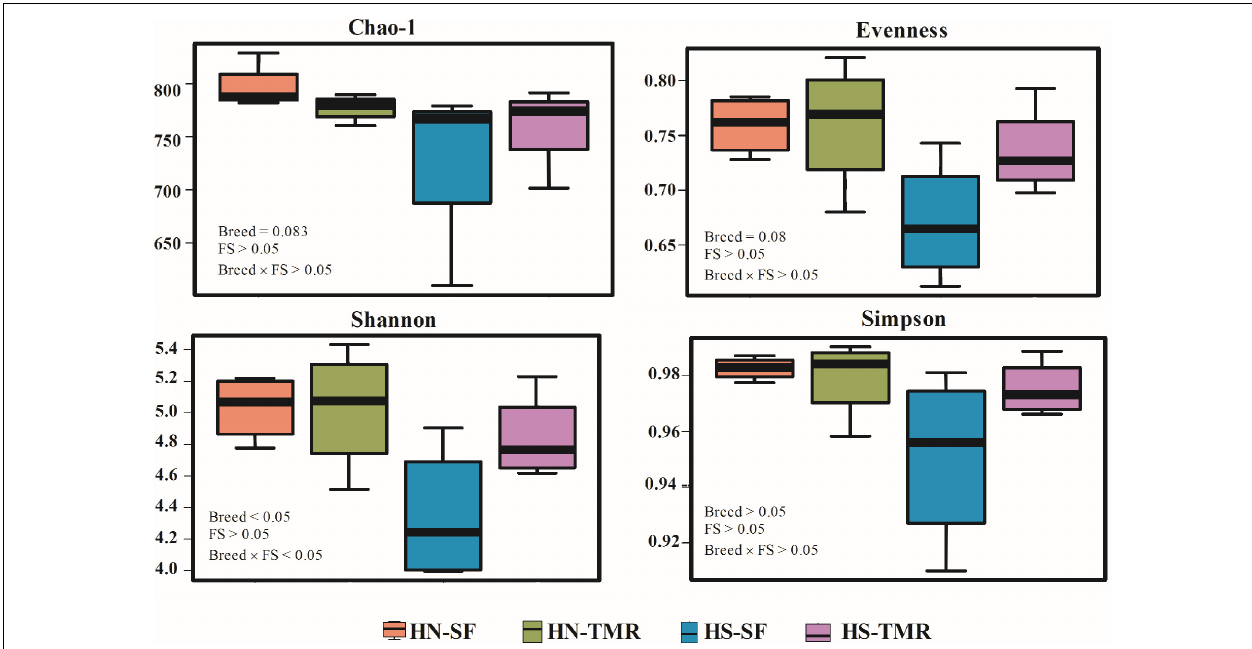
FIGURE 1 | Alpha diversity metrics of the bacterial/archaeal composition in the rumen of Hanwoo (HN) and Holstein (HS) steers fed a total mixed ration (TMR) or separate feed (SF) diet.